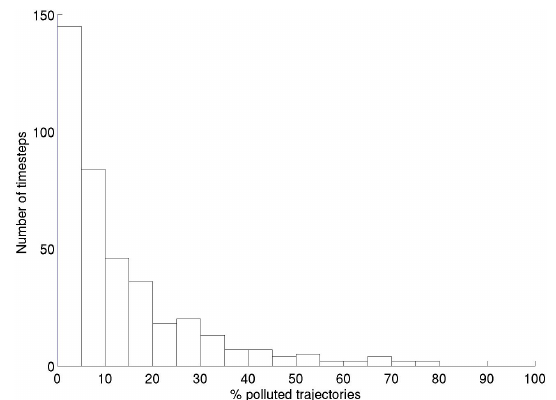
Figure 6. Histogram of the fraction of polluted WCB trajectories (in percent) as a function of the time steps obtained from all days on which more than 50 WCB trajectories start in the black